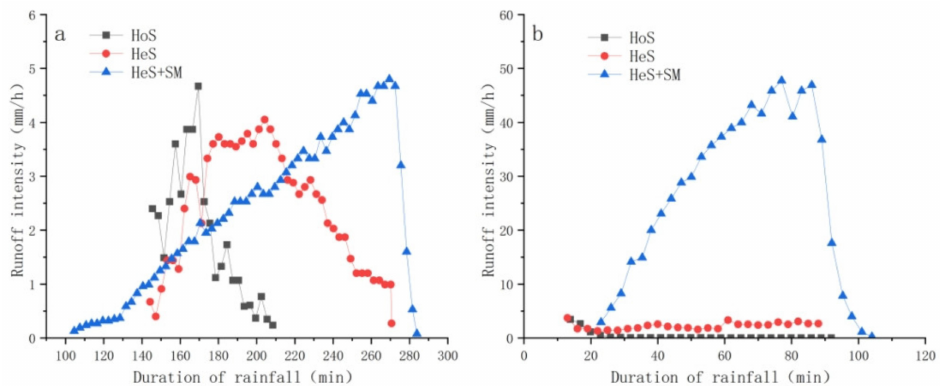
Figure 5. Subsurface flow process under different rainfall patterns ( a ) Long duration-low intensity rain; ( b ) Short duration-high intensity rain. HoS, Homogeneous soil. HeS, Heterogeneous soil. HeS + SM, Heterogeneous soil + Straw